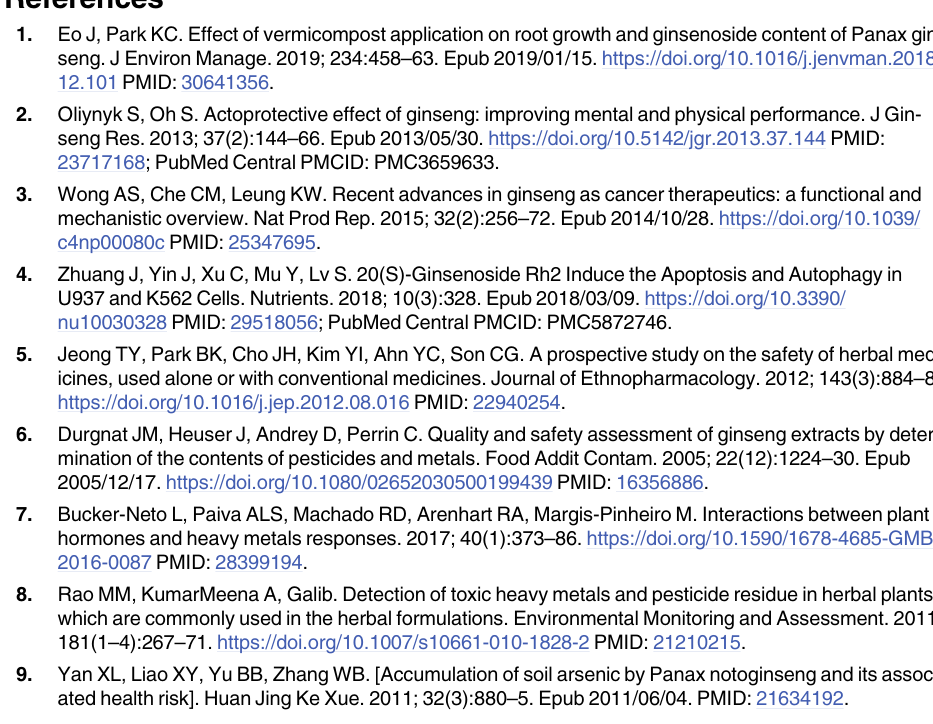
S1 Fig. Standard curves established for the quantification of different heavy